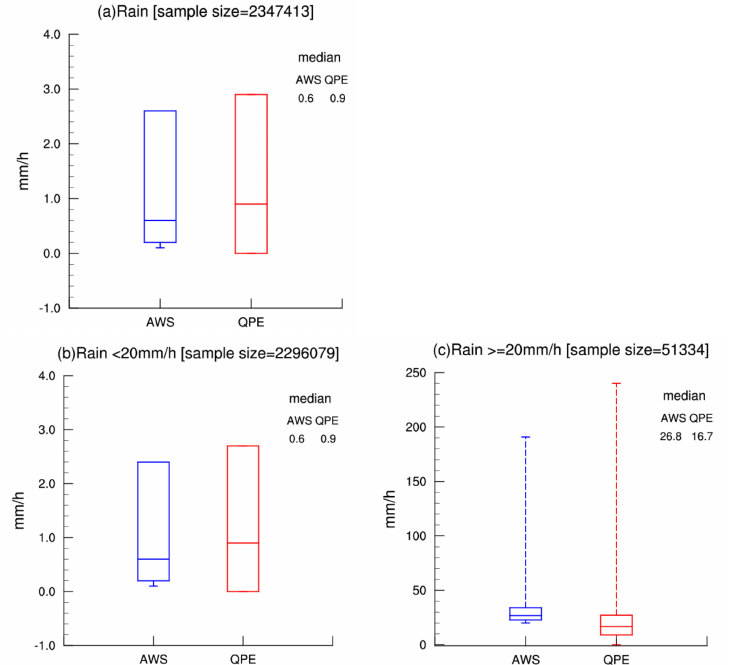
Figure 3. The box plot of the hourly rain for the AWS and radar QPE (unit: mm/h) based on ( a ) all samples, ( b ) samples of rainfall less than 20 mm/h, and ( c ) samples of rainfall larger than (including equal to) 20 mm/h. In each box, the top (bottom) of the box indicates the 75% (25%) quartile, and the middle of the box provides the median value. In ( c ), the maximum and minimum are shown with the highest and lowest